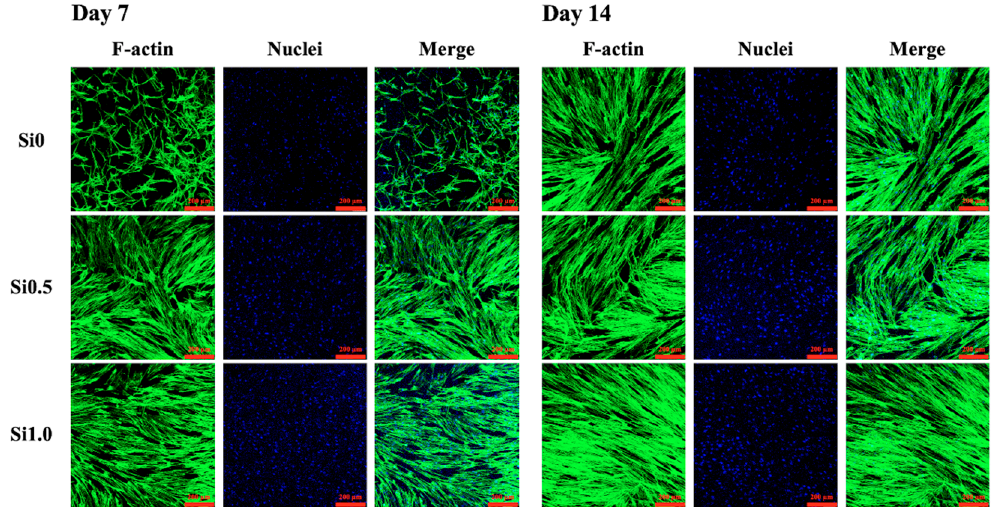
Figure 6. F-actin (green) and nucleus (blue) stain of human dermal fibroblasts (hDF) cultured on various hydrogels for 7 and 14 days. The scale bar is 200 μ m.